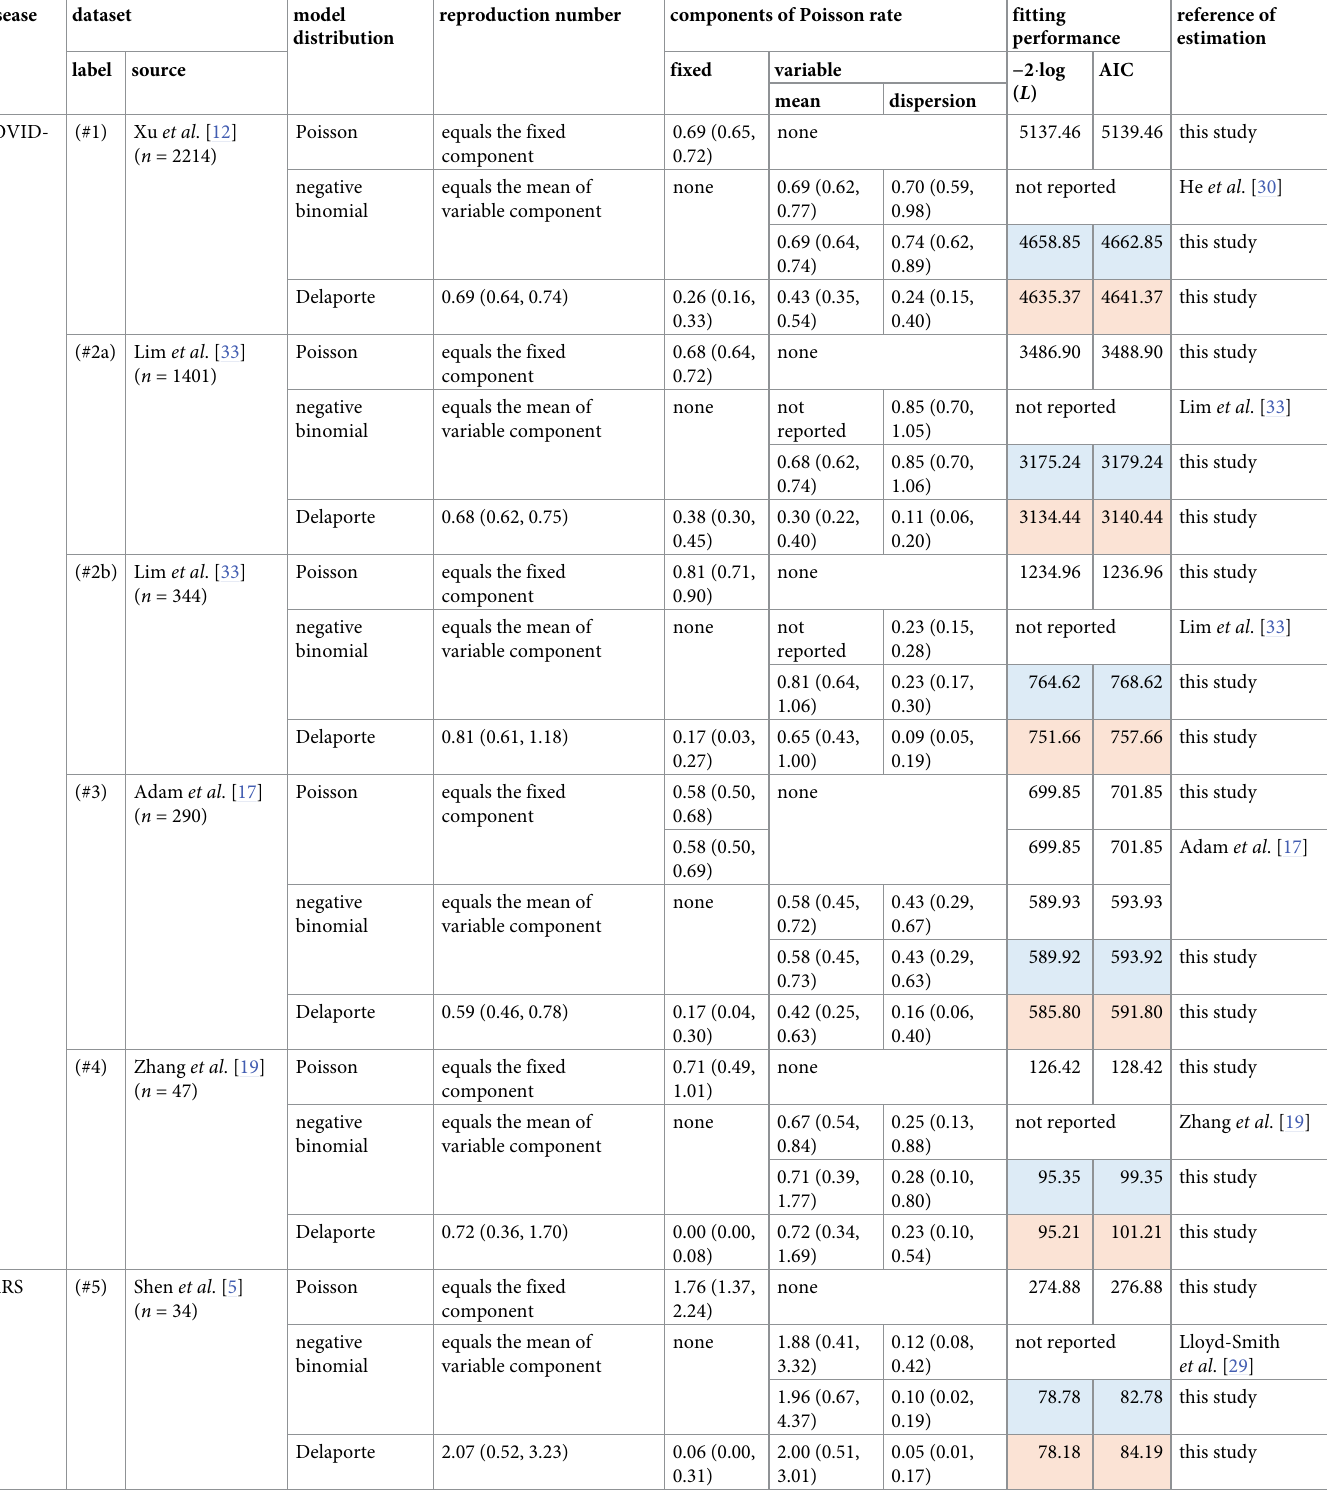
Table 1. The summary of parameter estimates of offspring distribution in the existing literature and this study. The ‘ − 2 � log( L )’denotes twice of the negative log-like- lihood. The highlighted estimates are considered as main results for Delaporte distribution (in red) and negative binomial (NB) distribution (in blue).